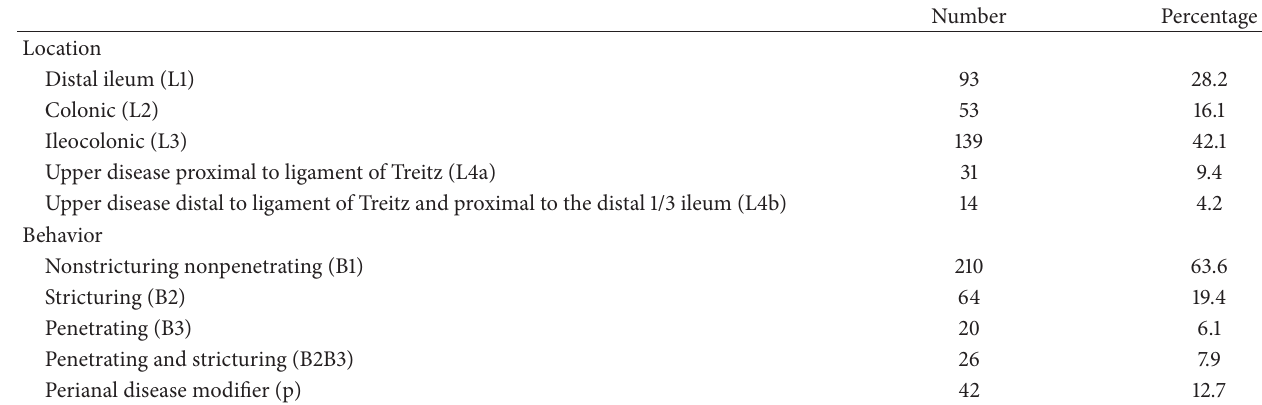
Table 3: Disease location and behavior at presentation in 330 patients with Crohn’s disease according to Paris